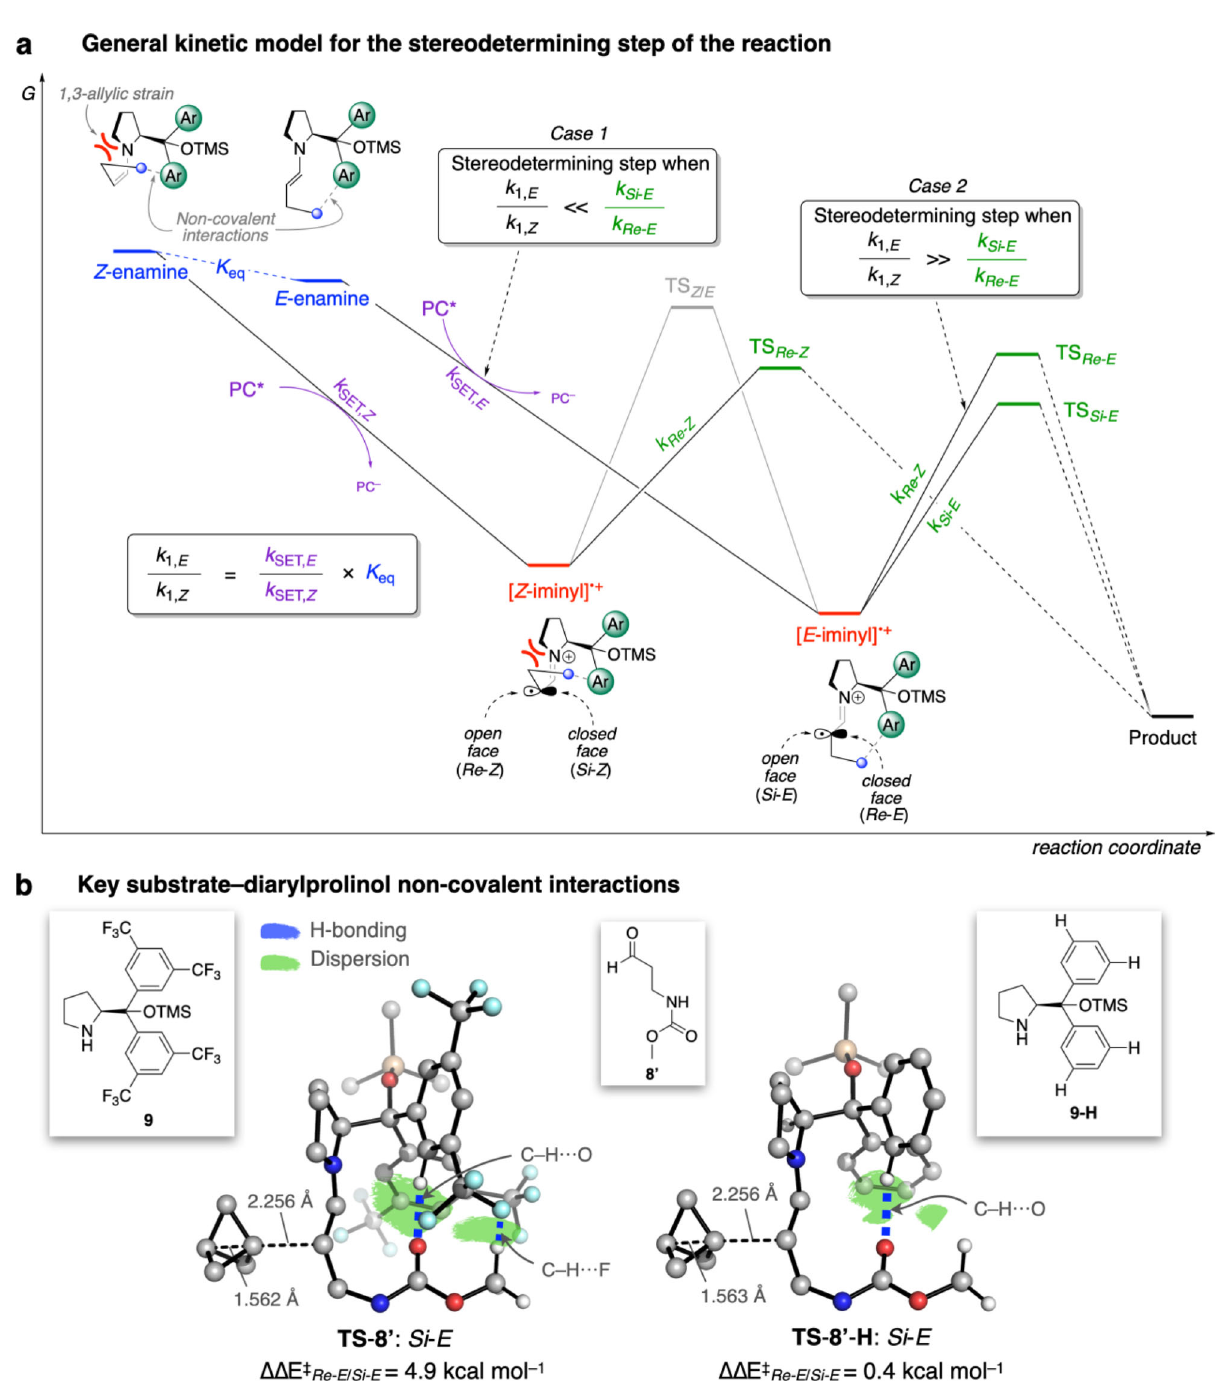
Fig. 5 Energy pro fi les for key species on the proposed reaction pathway and transition state geometries for addition of the iminyl radical cation to 1. a Populations of, and transitions between, key species involved in the stereodetermining steps of the reaction. PC photocatalyst, SET single-electron transfer. b Lowest energy constrained transition states for Si - E TS-8 ′ and TS-8 ′ -H , showing the most important non-covalent interactions between the sidechain and pyrrolidine substituents, calculated at the [SMD(DME)-B2GP-PLYP-D3BJ/def2-TZVPP//SMD(DME)-PBE0-D3BJ/def2-SVP] level of theory. Hydrogen atoms are omitted for clarity. Blue = hydrogen bonding. Green = dispersion